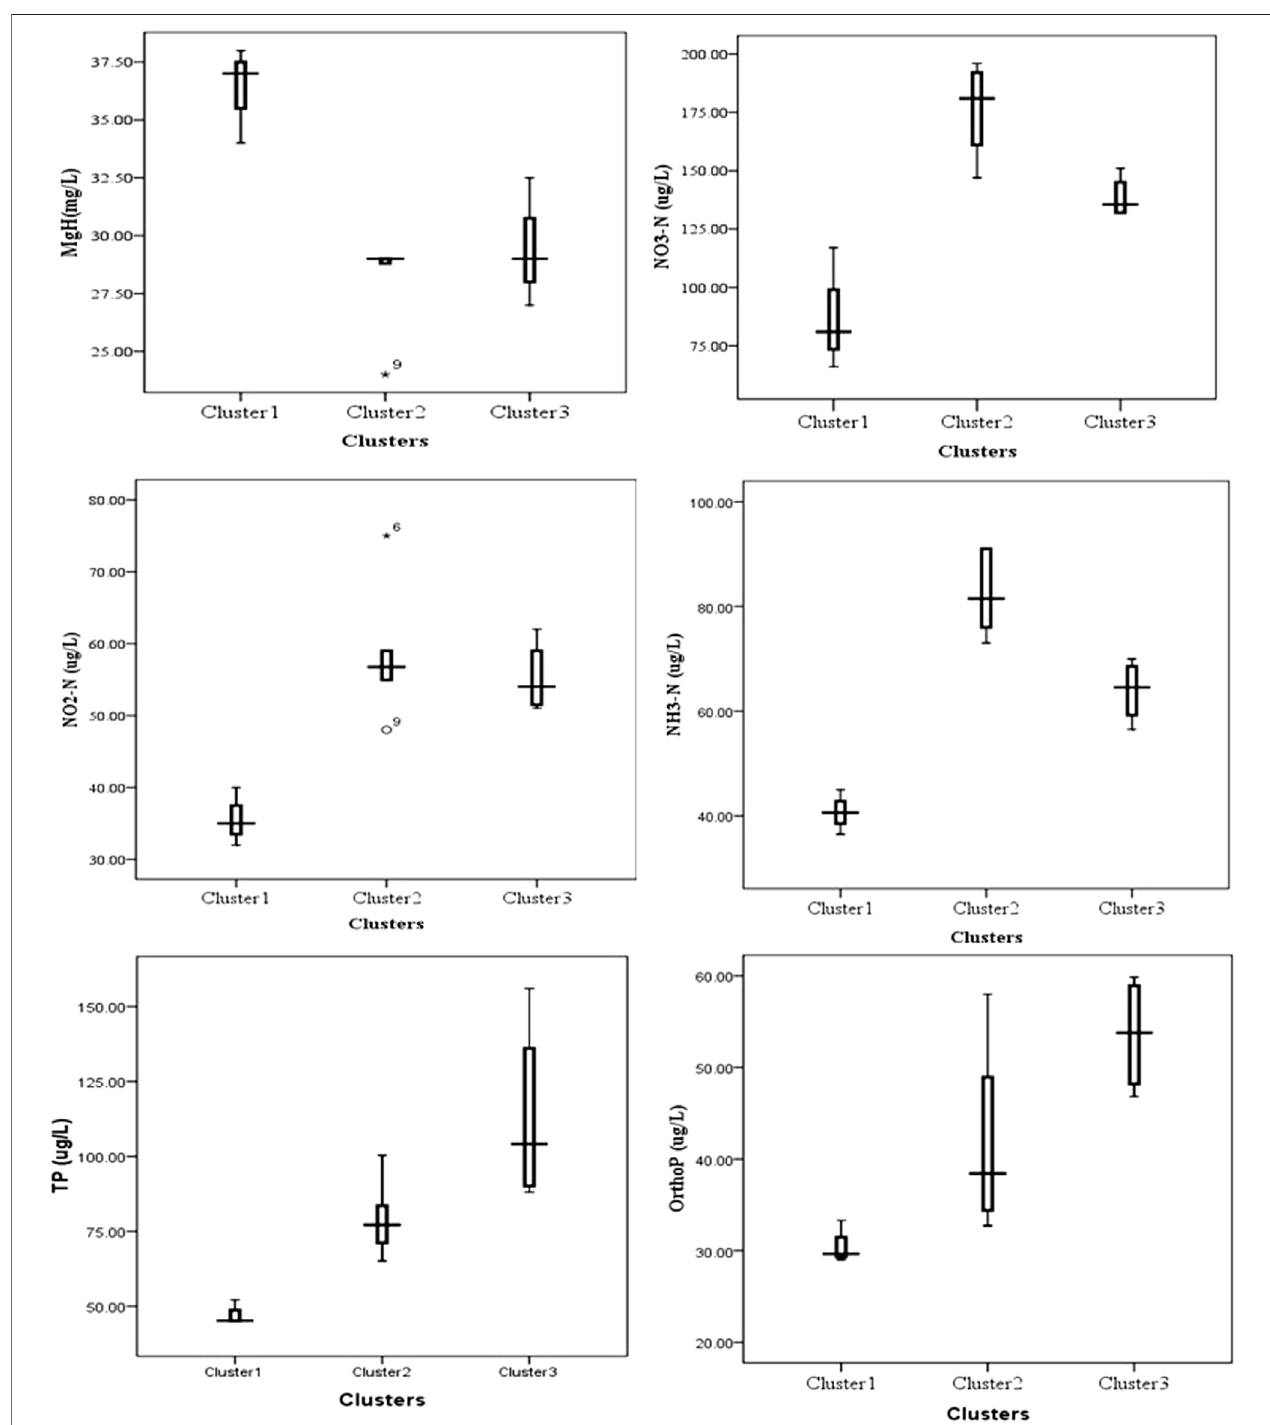
FIGURE 6 | Boxplots of parameters (Mg-H, NO 3 -N, NO 2 -N, NH 3 -N, TP, and OP) responsible for major variability throughout the HAL sites.